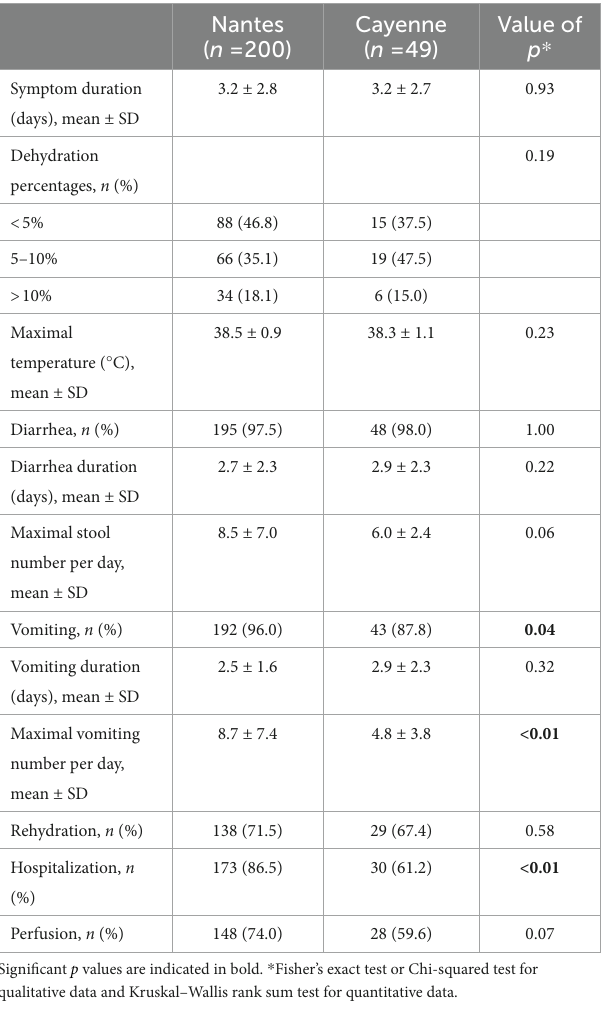
TABLE 2 Description of gastroenteritis